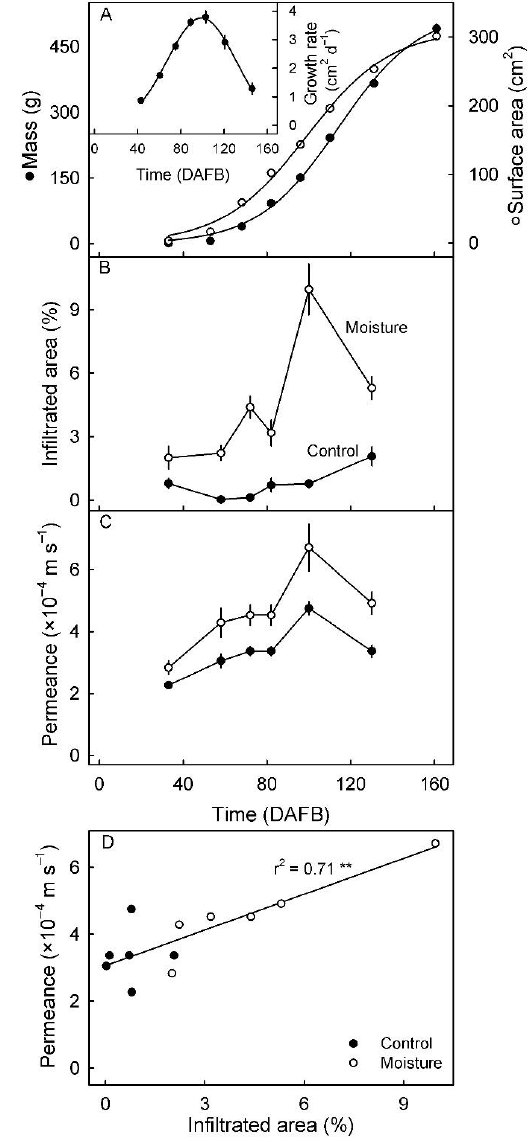
Figure 3. Developmental time course of change in fruit mass and surface area of mango cv. apple ( A ), microcracking following moisture exposure ( B ) and permeance to water vapor ( C ) following 8 days exposure to surface moisture. ( D ) Relationship between permeance to water vapor and microcracking ( D ). Untreated surfaces served as controls. Microcracking was indexed by quantifying the area infiltrated with acridine orange. X-axis scale in A, B and C is days after full bloom (DAFB). N = 20 (mass and surface area), 40 (microcracking) and 13–15 (permeance). Data represent the means ± SE. Significance of coefficients of determination (r 2 ) at p ≤ 0.01 is indicated by **. The time course of change in infiltrated area and in skin permeance after moisture exposure was terminated revealed a decrease in both infiltrated area and in